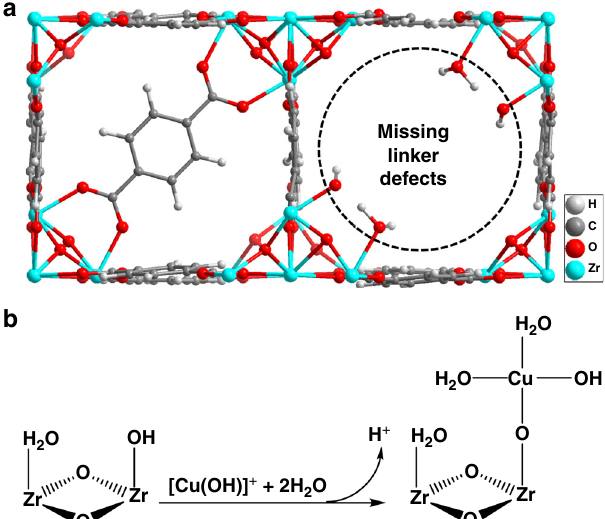
Fig. 1 Using defective nodes to deposit Cu species. a A linker missing in the UiO-66 structure is replaced by two – OH/OH 2 species, which are active for ion exchange to deposit metal onto the Zr 6 nodes of the MOF. b Possible reaction for Cu deposition (ion exchange) in aqueous